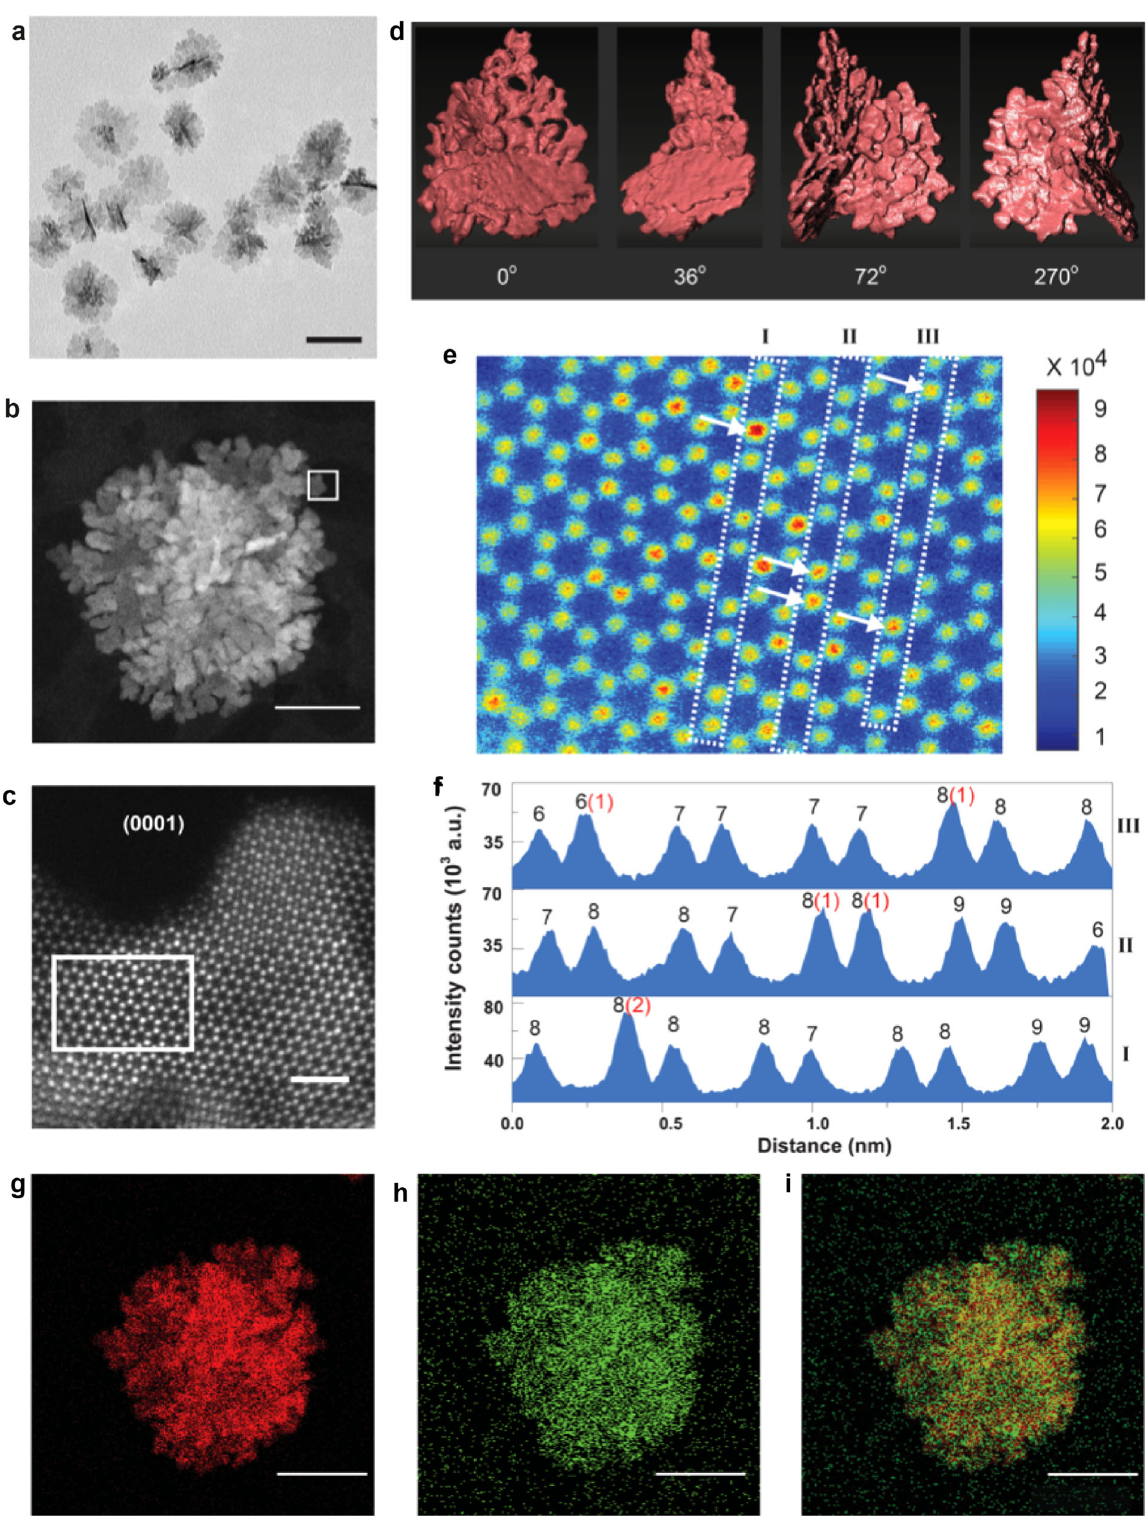
Fig. 1 Morphological and structural characterization of RuIr-NC. a Transmission electron microscopy (TEM) and b high-angle annular dark- fi eld (HAADF)-scanning TEM image. c Atomic-resolution HAADF-STEM image from the selected area in ( b ) showing the extended (0001) plane. d 3D tomographic reconstruction of RuIr-NC . e The magni fi ed image of the selected area in ( c ), where the colour bar represents the Gaussian intensity of the electron diffraction located at the column position. f Quantitative analysis of the Ru and Ir distribution at lines I – III in ( e ). The black and red numbers above each peak represent the number of total and Ir atoms in the corresponding position, respectively, and the Ir positions are noted by arrows in ( e ). Elemental maps showing g Ru- L (red), h Ir- M (green) and i the overlay of RuIr-NC in ( b ). The scale bars in ( a ), ( b ), ( c ), and ( g ‒ i ) are 50, 20, 1, and 25 nm,